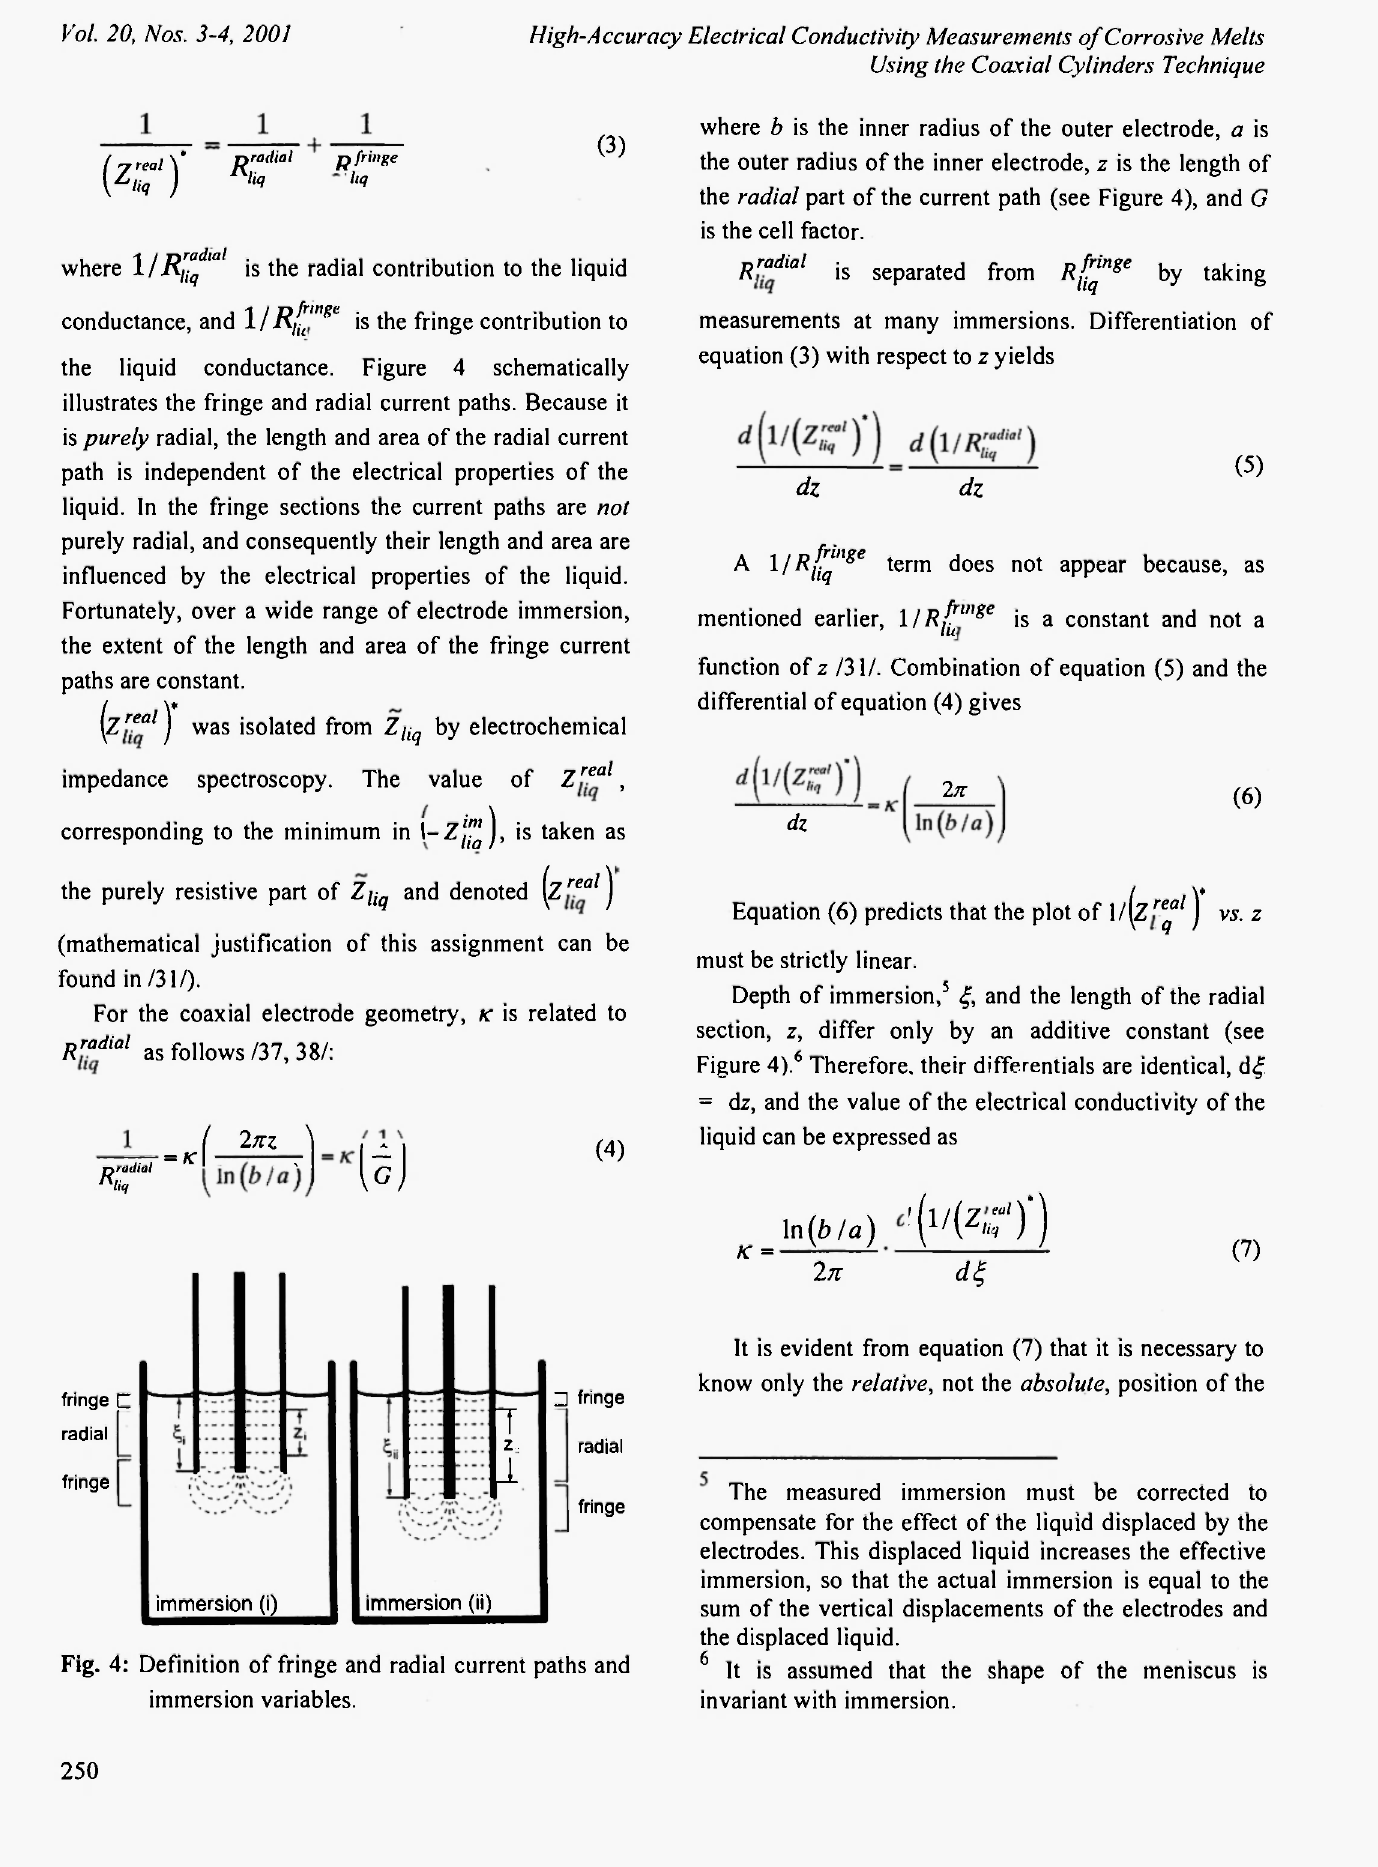
Fig. 4: Definition of fringe and radial current paths and immersion